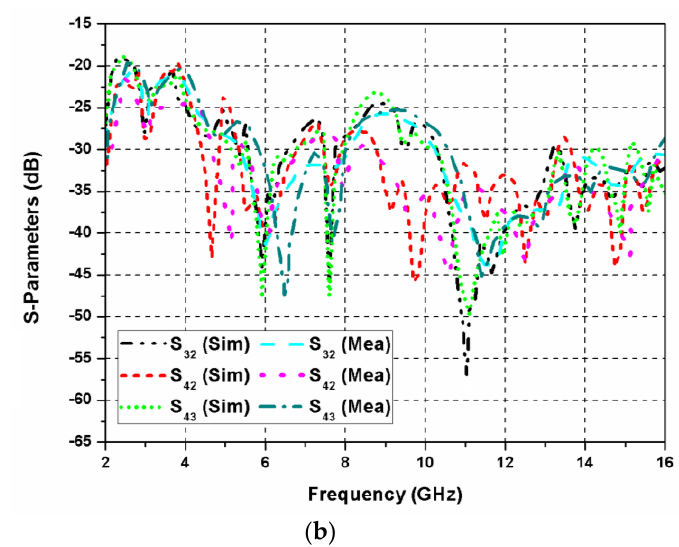
Figure 8. S-parameters (simulated and measured) of the MIMO antenna at ( a ) port-1; ( b ) other ports.